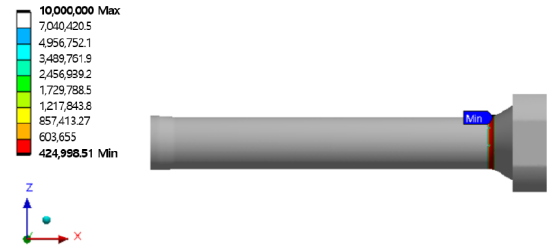
Figure 24. Results of the fatigue analysis of stem.